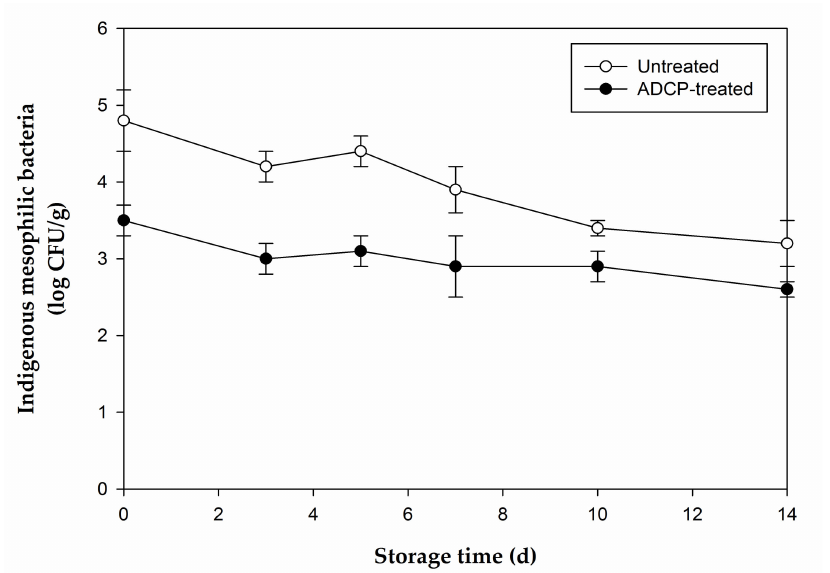
Figure 1. The effect of atmospheric dielectric barrier discharge cold plasma (ADCP) treatment on the growth of mesophilic aerobic microorganism in chicken breast salad during storage at 4 ◦ C. Error bars represent standard deviation ( n =